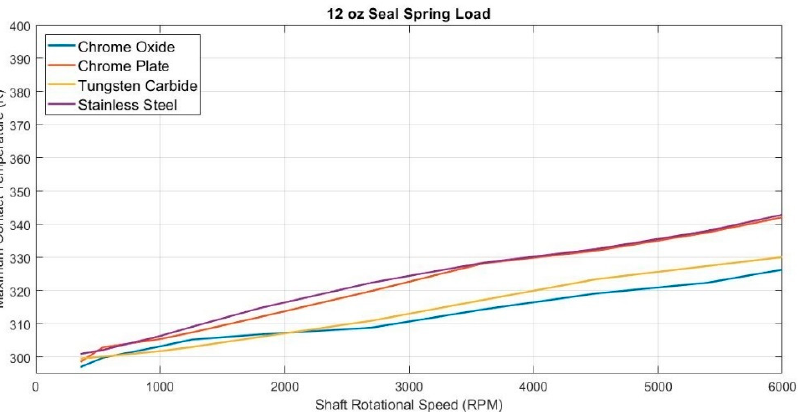
Figure 9. Maximum contact temperature at sealing interface for all 12 oz spring loads, comparing temperatures reached for CO, CP, TC and SS sleeves, reflecting mean values of two datasets taken for repeat experiments.